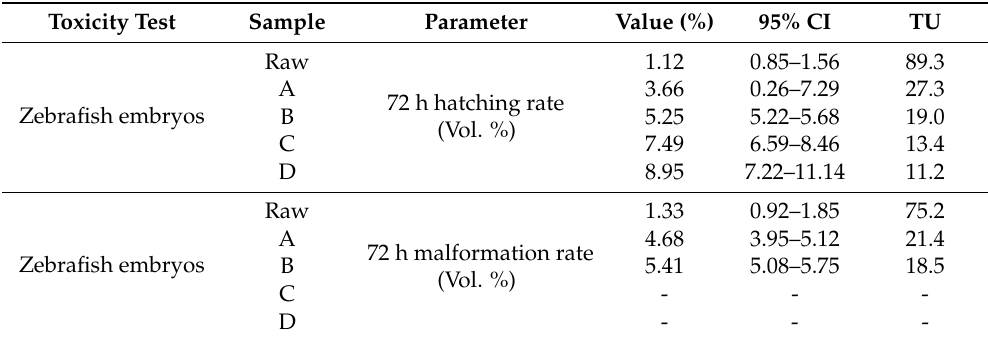
Table 4. Seventy-two hour hatching rate and malformation rate of zebrafish embryos exposed to the raw landfill leachate and effluent from four treatment